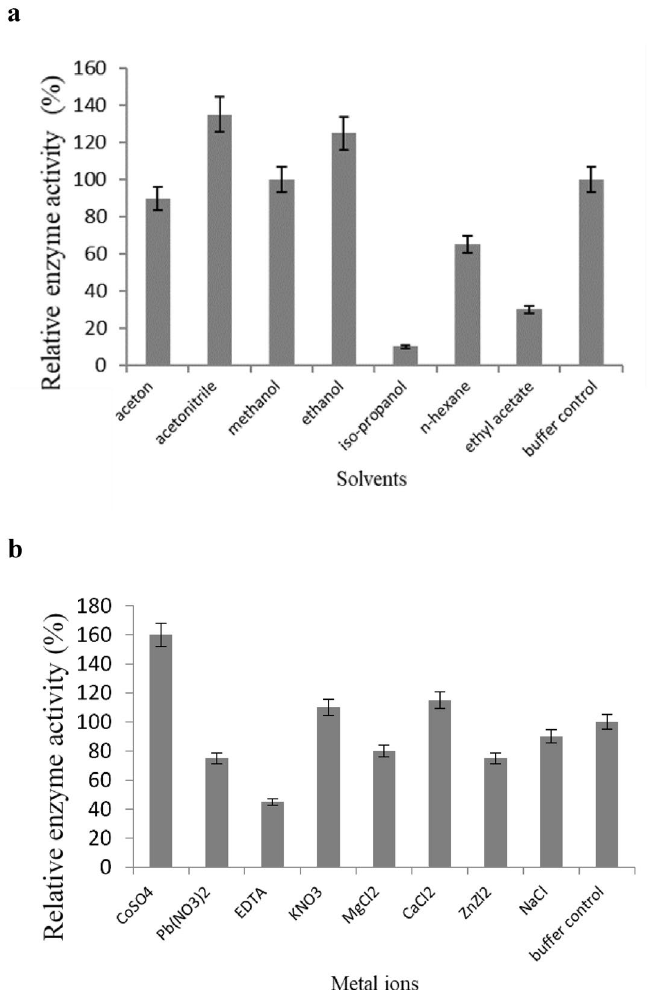
Figure 8. Relative enzyme activity graphs in the presence of different solvents ( a ) and metal ions and EDTA (1 mM each). ( b ) The enzyme activity was assayed as described in the materials and methods section. Data are expressed as mean ± SD of triplicate